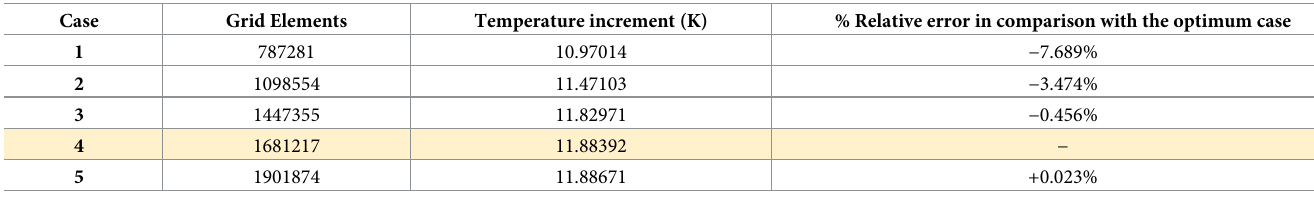
Table 2. Quantitative amounts and relative errors of different